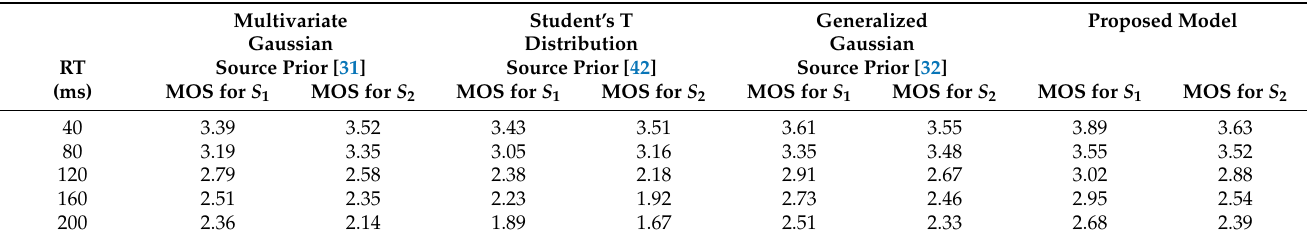
Table 8. Average MOS results of the subjective evaluation for the second model shown in Figure 2 with variable RT for multistage BSS models having different source